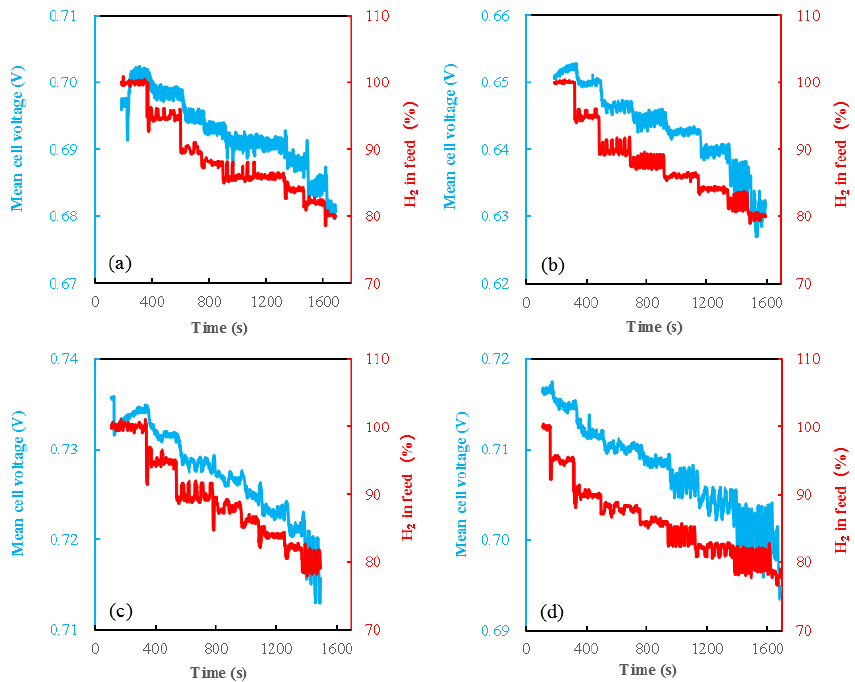
Figure 3. Test results of the fuel cell stack at different current densities: ( a ) 0.2 A ∙ cm − 2 ; ( b ) 0.6 A ∙ cm − 2 ; − 2 ; ( d ) 1.4 A · cm − 2 ( c ) 1.0 A ∙ cm − 2 ; ( d ) 1.4 A ∙ cm − 2 . ( c ) 1.0 A · cm